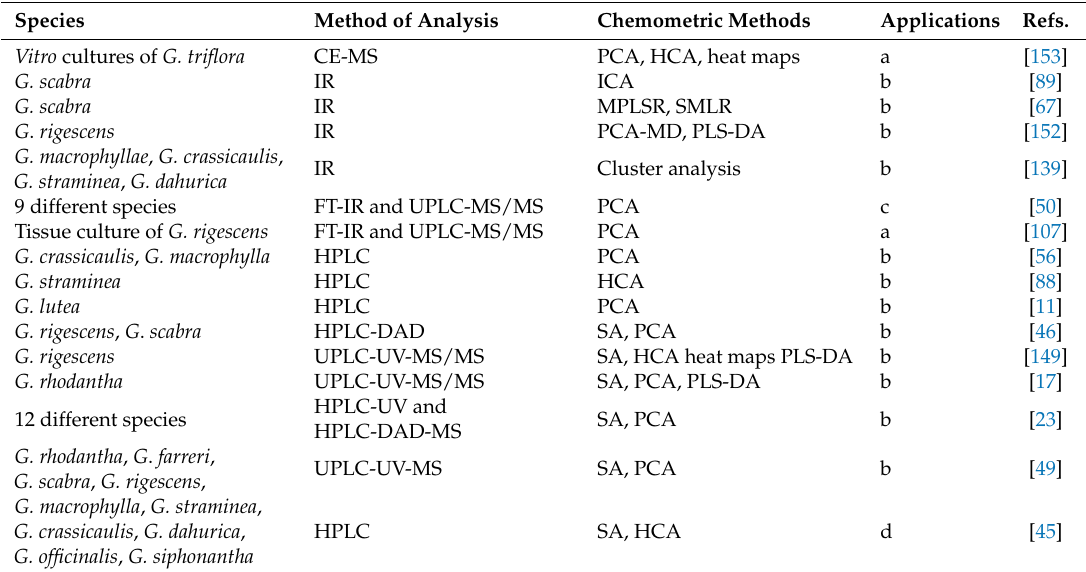
Table 5. Applications of chemometric in Gentiana